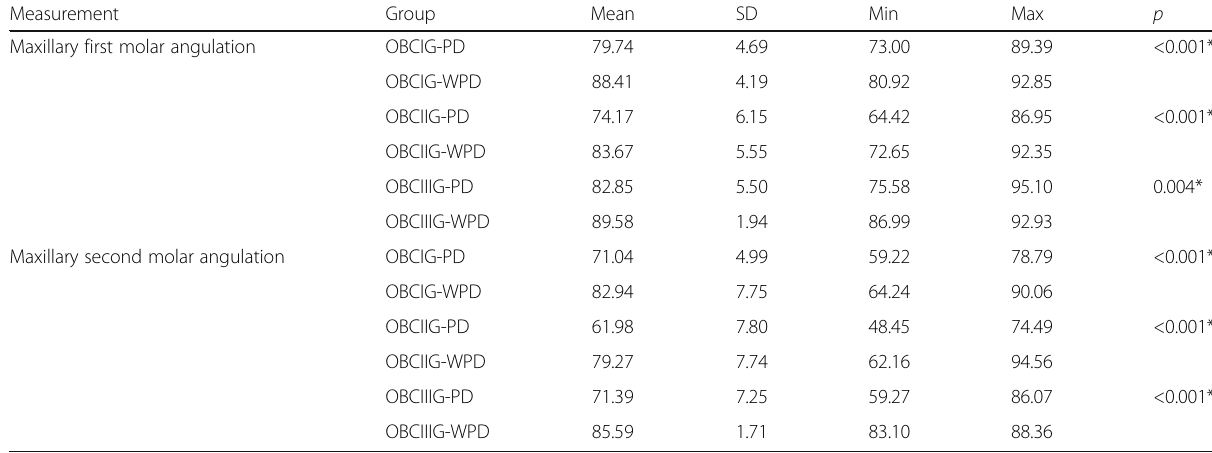
Table 4 Maxillary molar angulation according to maxillary posterior dentoalveolar discrepancy and facial growth pattern